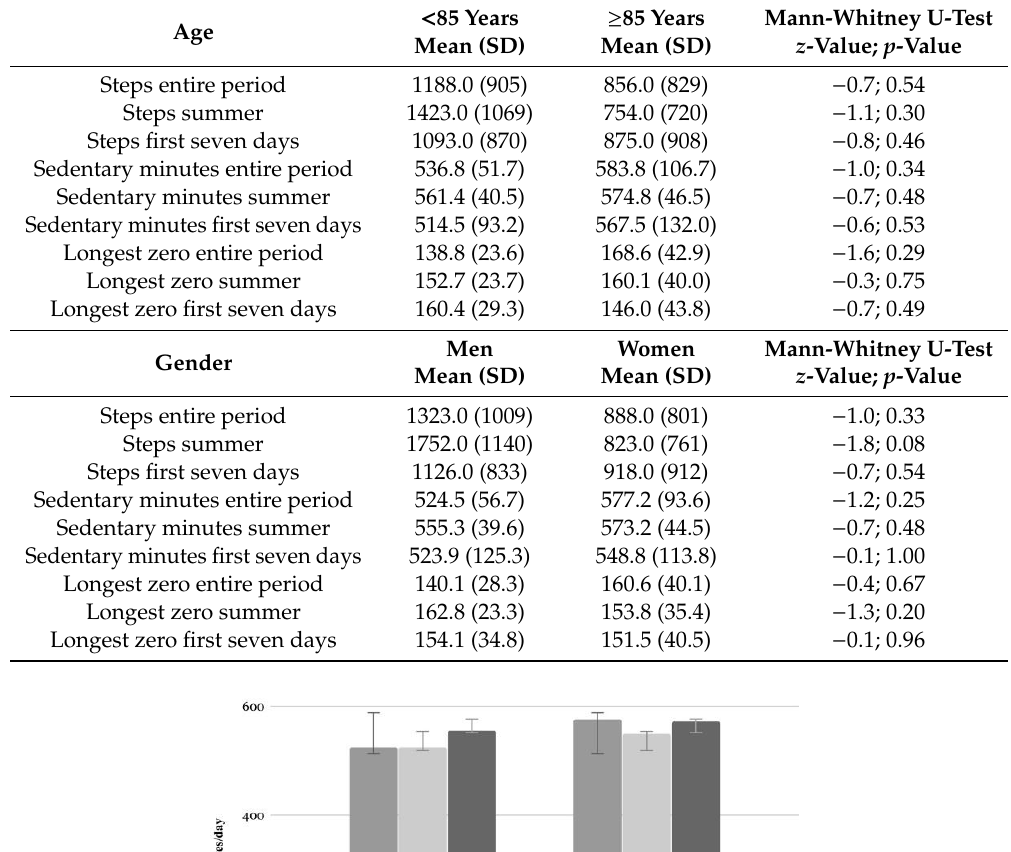
Table 4. Di ff erence between age groups and gender for daily PA level. Table 4. Difference between age groups and gender for daily PA